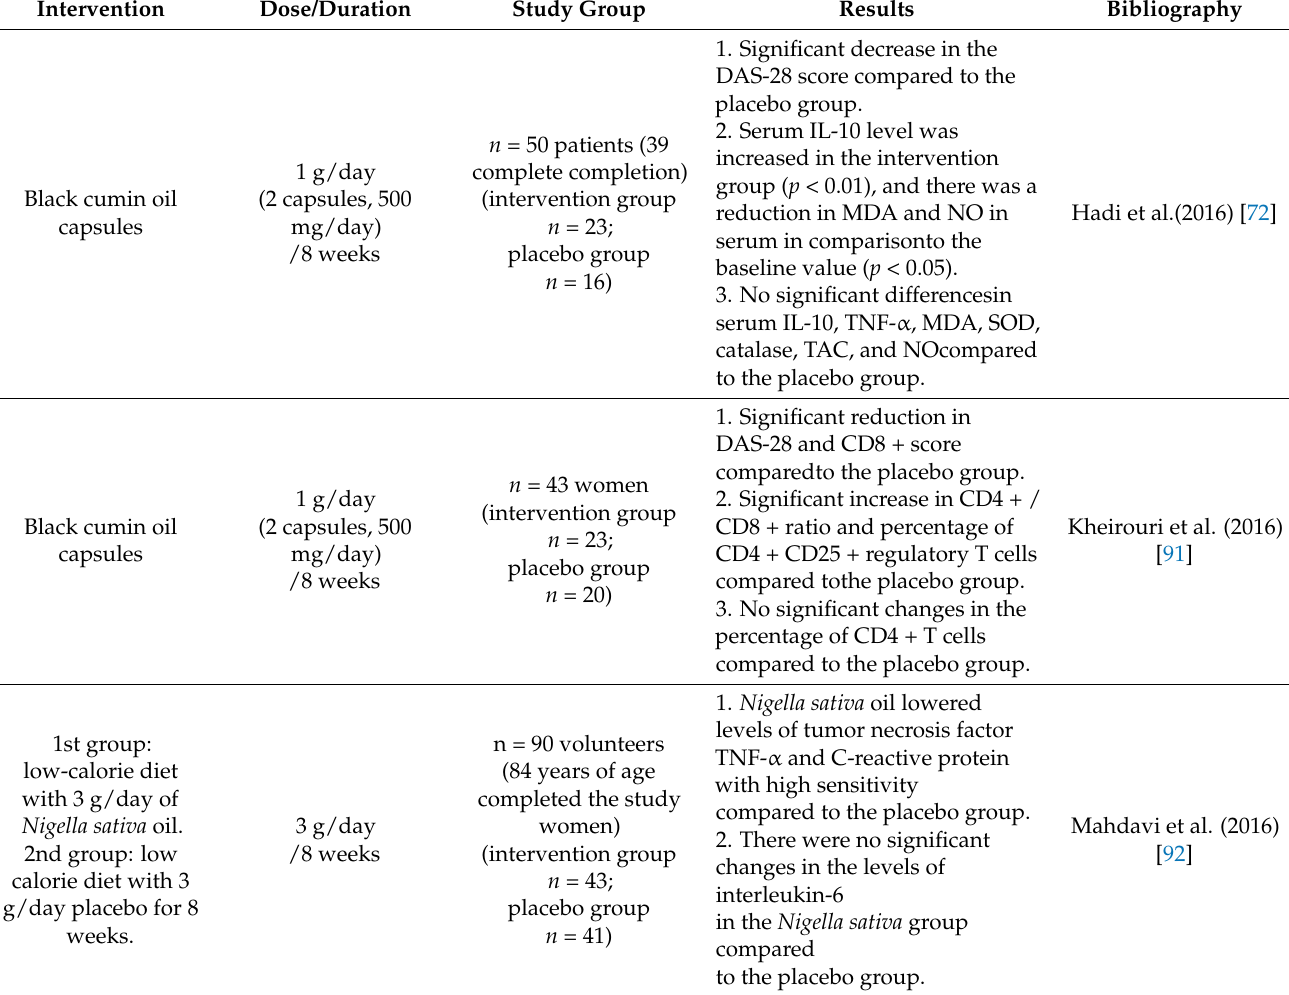
Table 4. Characteristics of human studies of the effects of Nigella sativa on rheumatoid arthritis. Intervention